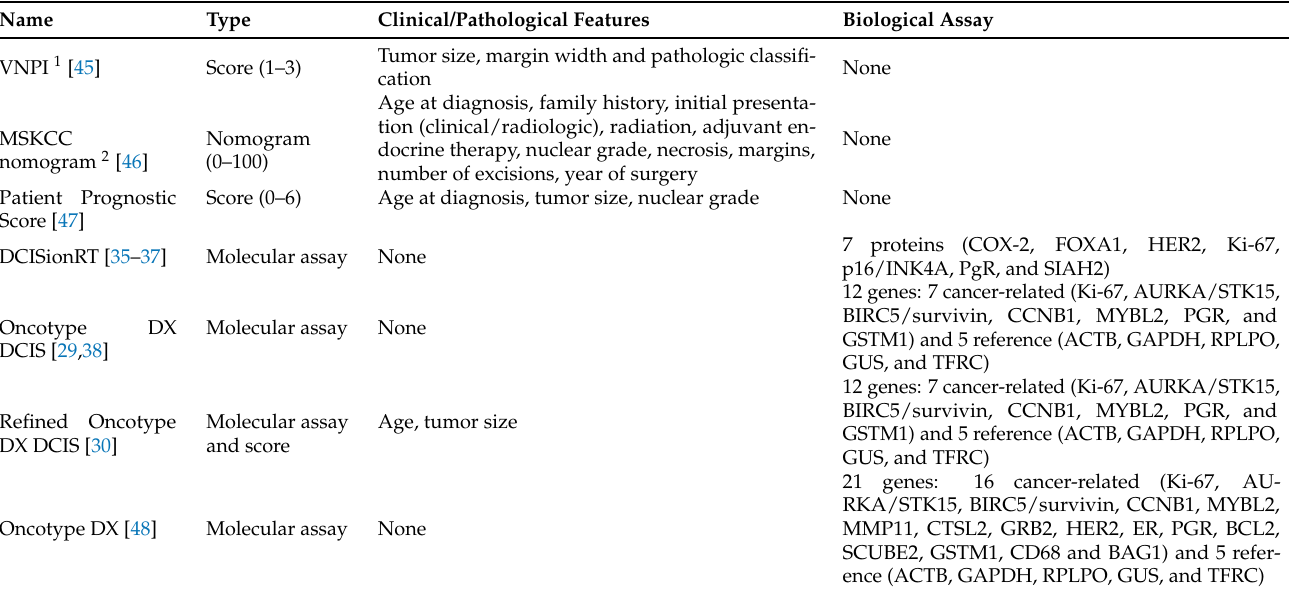
Table 4. Risk stratification tools in